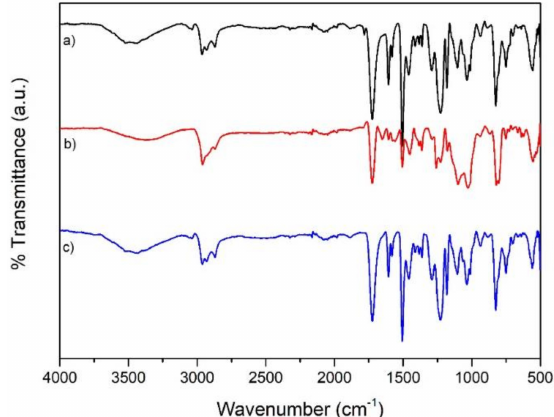
Figure 4. FTIR spectra of sample E-Mod_2 ( a ), sample E-Mod_2 in liquid ( b ) and sample E-Mod_2 in gas ( c